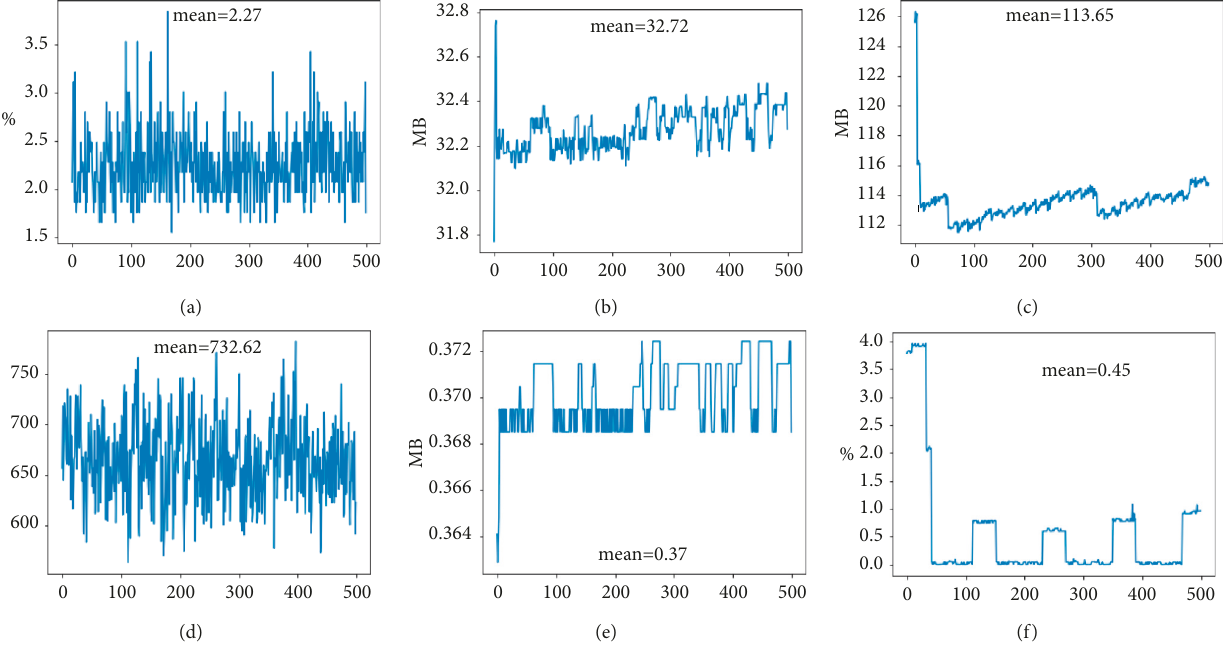
Figure 8: The usage of the CPU, GC, and memory. (a) Processor time. (b) Private bytes. (c) Bytes in all heaps. (d) Handle count. (e) Pool paged bytes. (f) Time in GC.